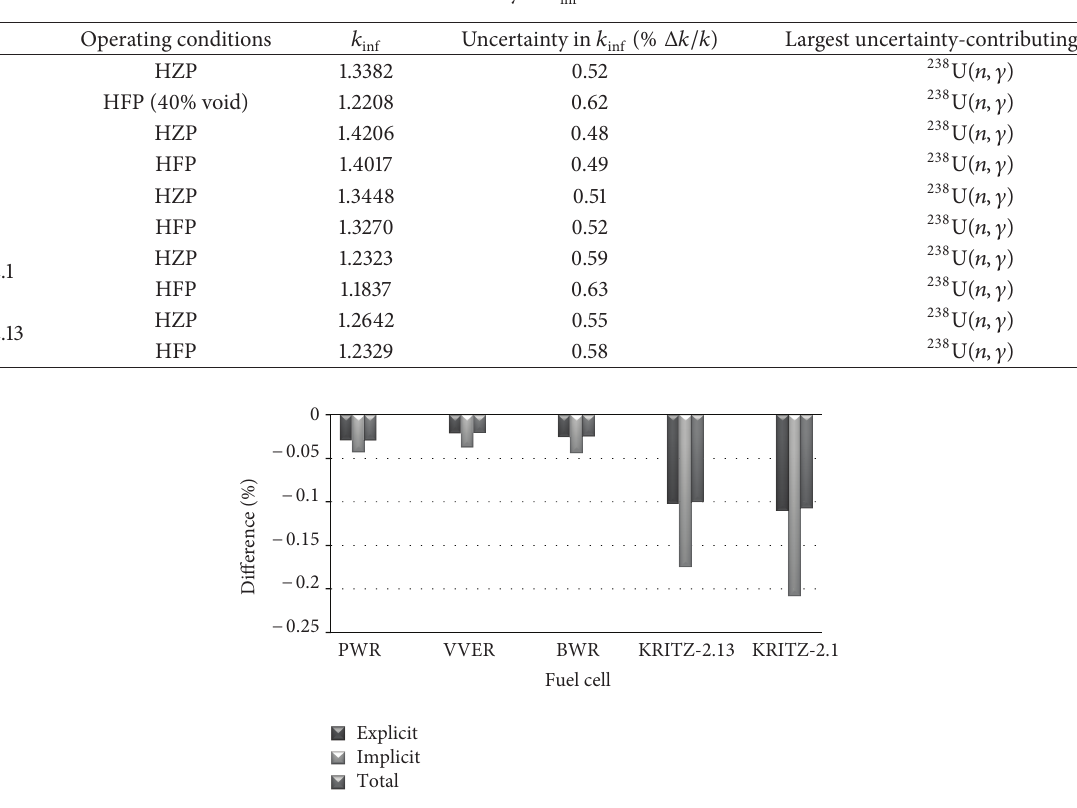
Table 1: Uncertainty in 𝑘 inf in LWR unit cells.